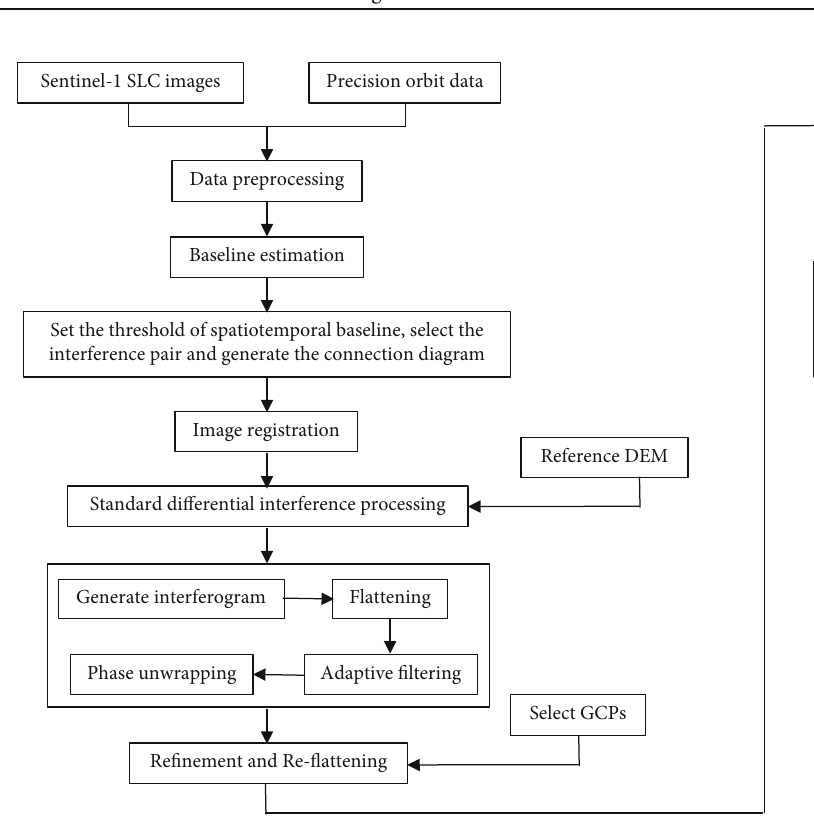
Figure 4: Data processing fl ow.